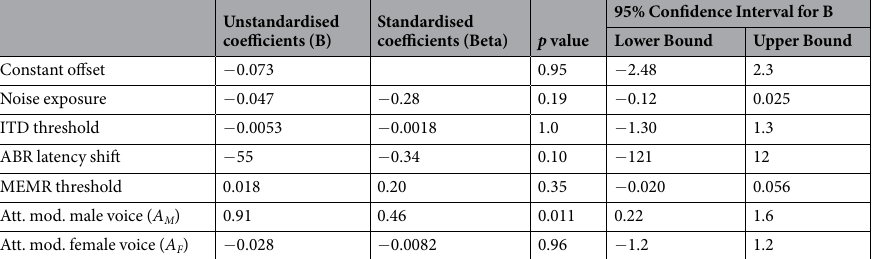
Table 1. We used multiple linear regression to determine which of the auditory measures could explain the variability in speech-in-noise perception. After correcting for multiple comparisons (FDR, q = 0.1) we obtained only the relative attentional modulation of the brainstem response to the male voice, A M , as a significant predictor; this could explain 38% of the variance in the SRTn.